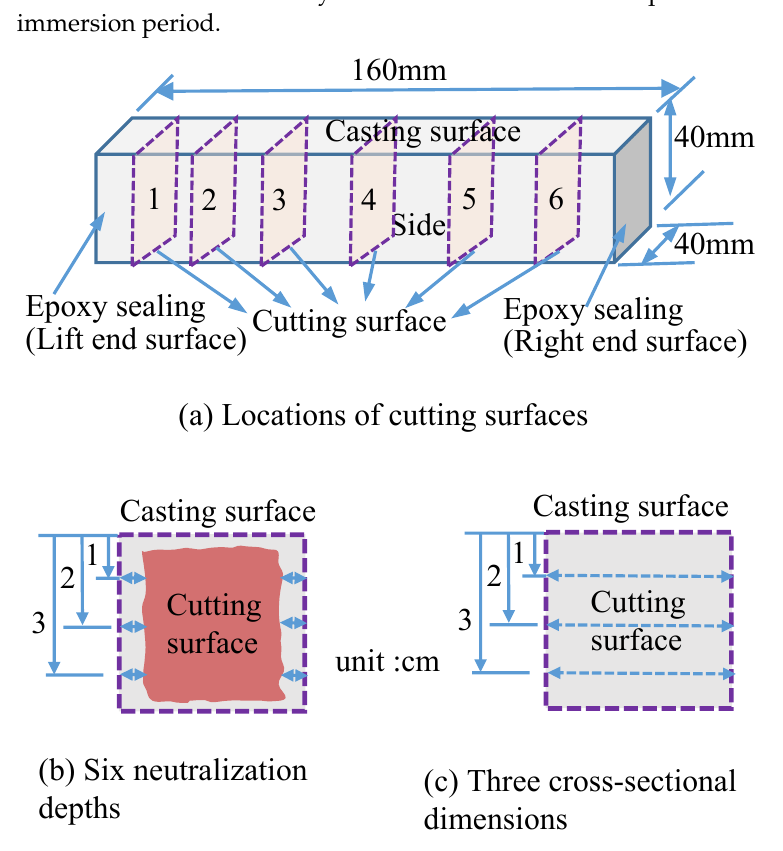
Figure 1. Locations of cutting surfaces ( a ), neutralization depth measurement ( b ), and sectional di- mension measurement ( c ).